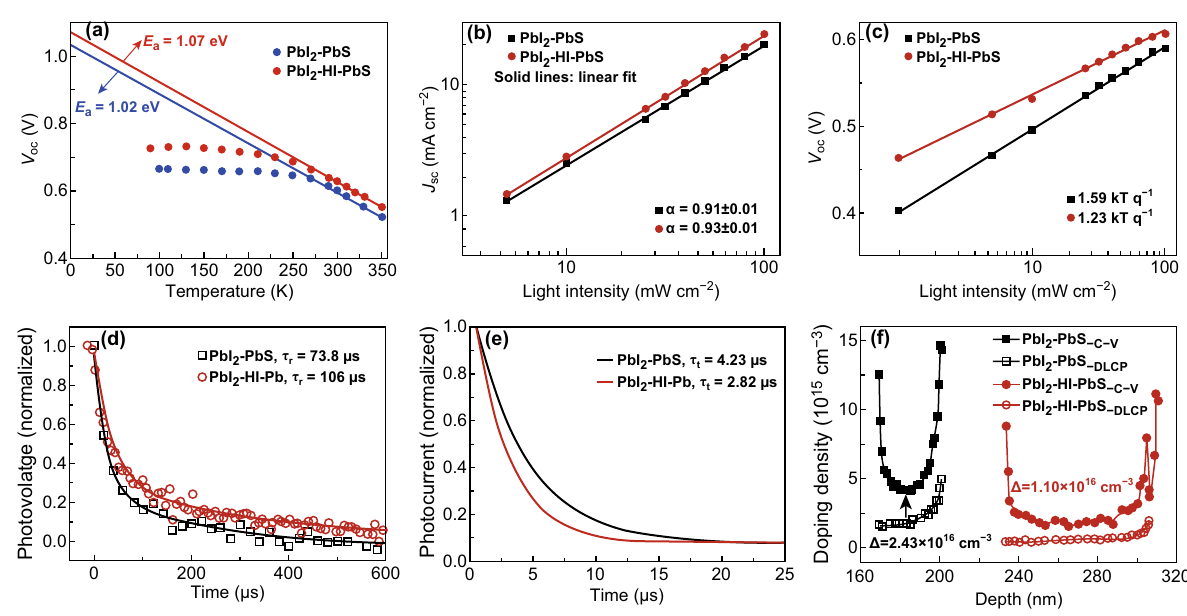
Fig. 6 Physical characterizations of w/o and w/HI devices. a Temperature dependence of V oc under 100 mW cm −2 light intensity. Solid line: linear fits. b Light‑intensity dependence of J sc . Solid lines: linear fits. c Light‑intensity dependence of V oc . Solid lines: logarithmic fits. d Charge recombination and e transport lifetime calculated by TPV and TPC, respectively. f Interfacial defects analysis from C – V and DLCP